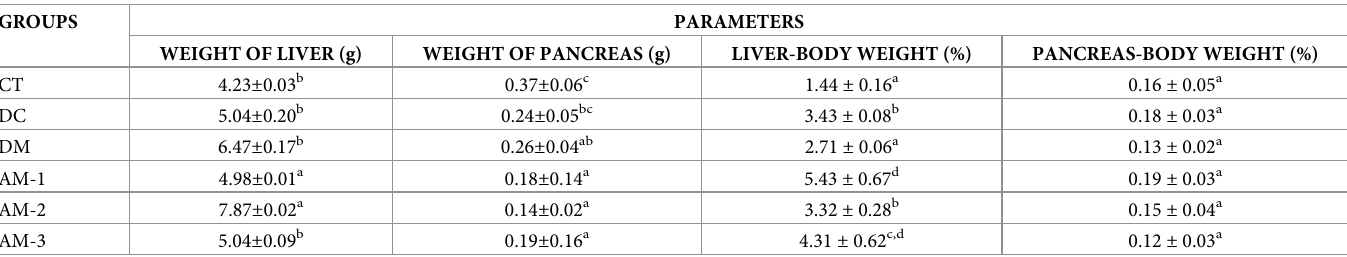
Table 4. Organ weight and organ-body weight ratios of alloxan-induced male Wistar rats administered orally with aqueous extract of A . muricata peels.